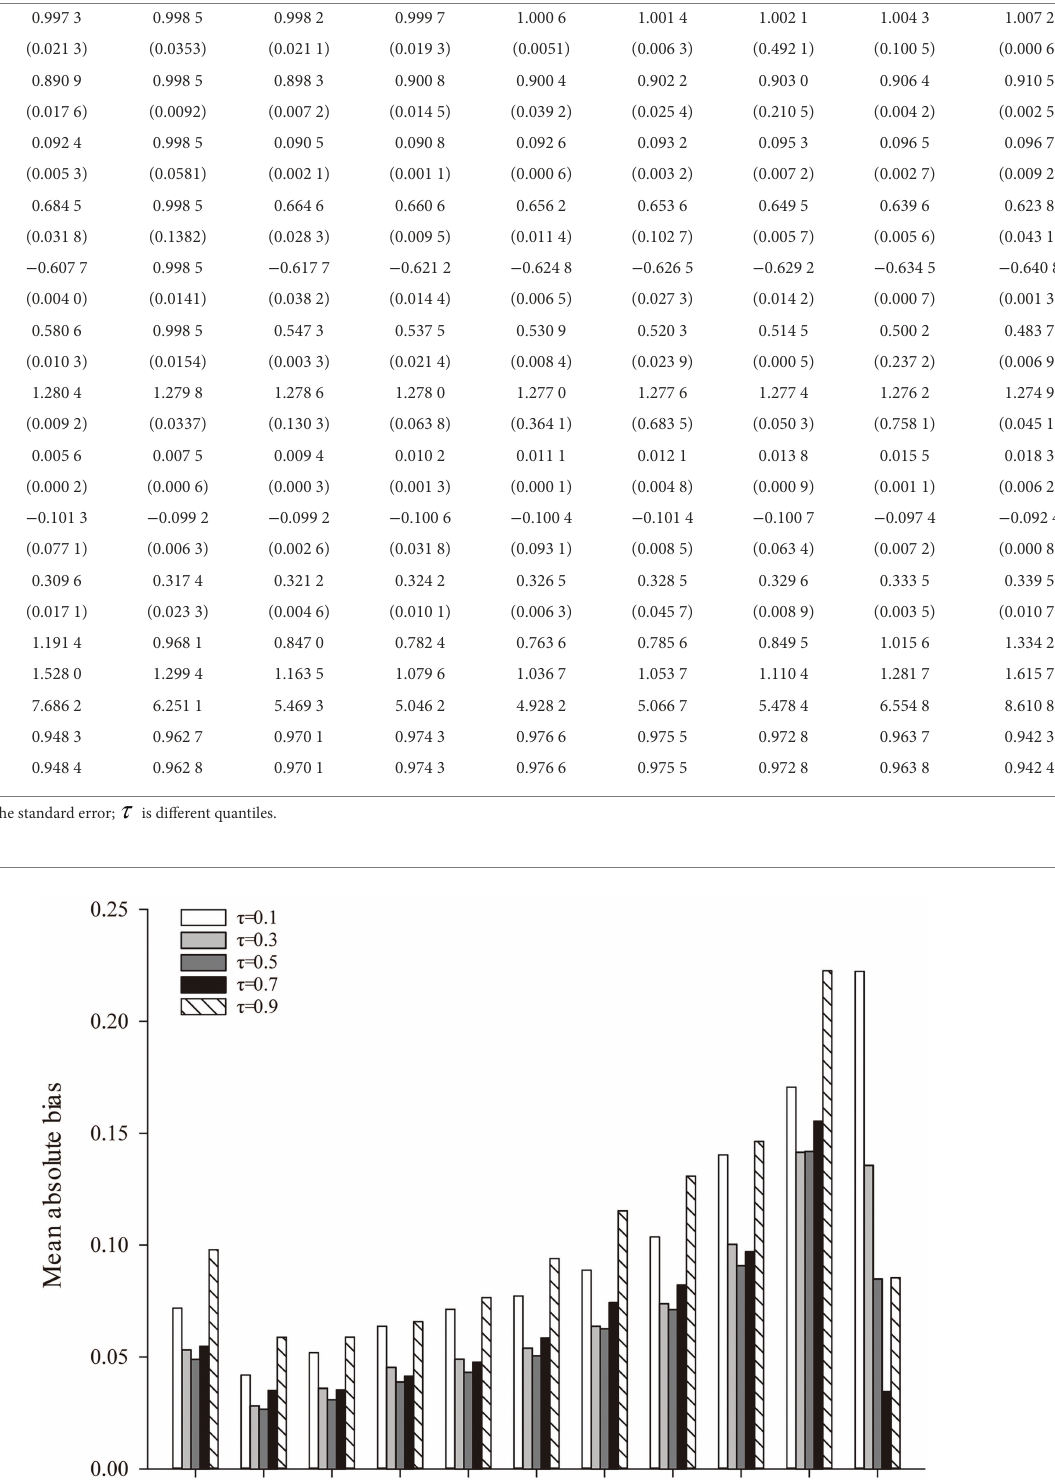
TABLE 8 Fit parameters and statistics of basic models with density factors at different quantiles. Parameters τ = 0.1